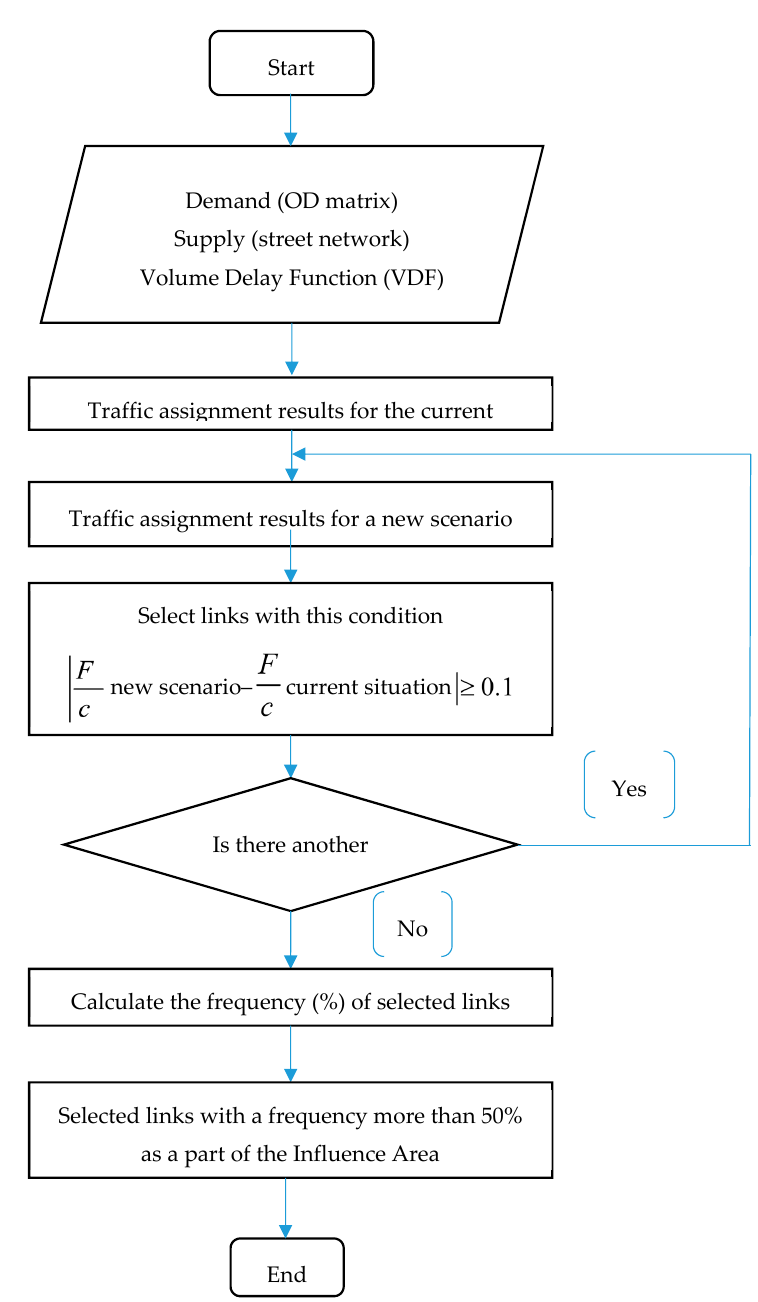
Figure 4. A flowchart of specifying influence area (IA) process.